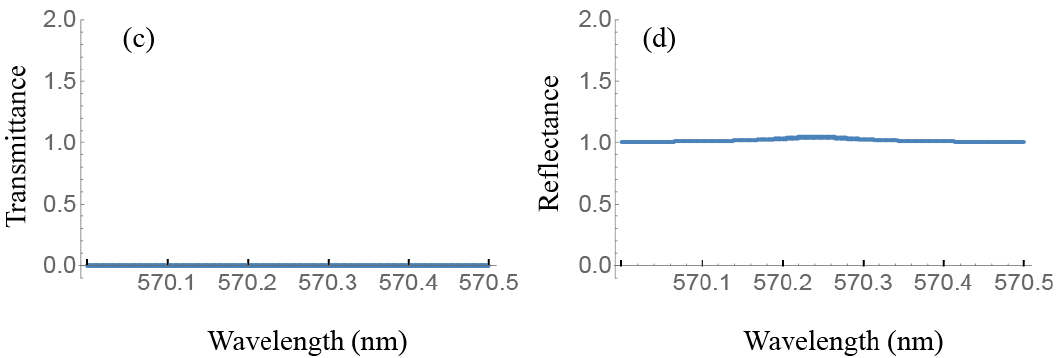
Figure 5. Transmittance ( a ) and reflectance ( b ) versus wavelength for the lasing mode of the lowest threshold gain of the DML10 sample; ( c , d ) are the transmittance and reflectance for the non-diffracting eigenstate under the same gain conditions. A phase jump of π /2 in the twisting angle was considered in the middle of the cell.